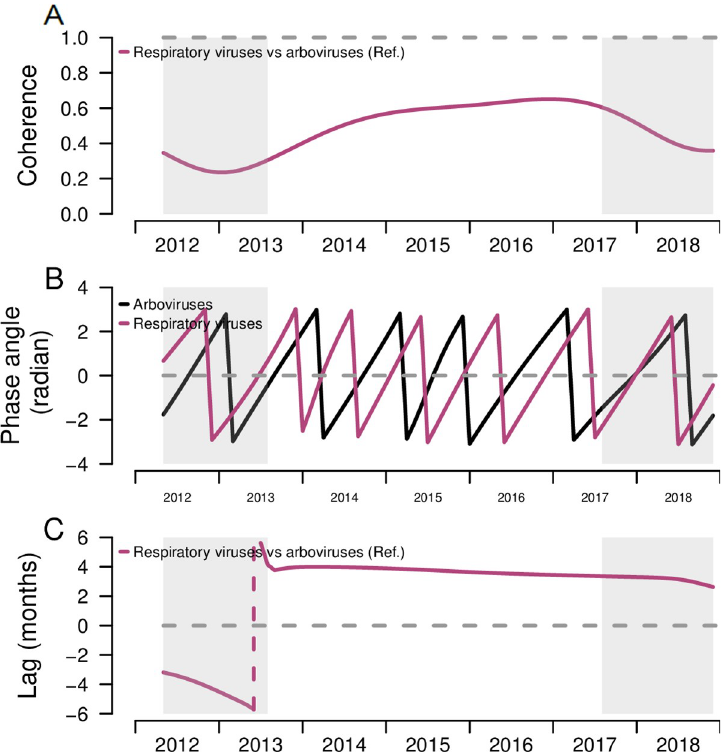
Fig 3. Coherence, phase angles, and lag of respiratory viruses and arboviruses among pediatric patients and comparison of both epidemic patterns, Sentinel Enhanced Dengue Surveillance System (SEDSS), Southern Puerto Rico, 2012–2018. A) Coherence comparing the similarity between the overall respiratory infection seasonal patterns to the arboviral infection patterns. Dashed line at 1 represents identical seasonal patterns and coherence at 0 refers to no association of two seasonal time-series. B) Phase angles of seasonal cycles of total respiratory infections and arboviral infections. C) Phase differences comparing the timing of respiratory infections seasonal cycles to arboviral infection epidemics. Dashed line at 0 refers to patterns of individual and overall respiratory infections occurring at the time (i.e. no difference in phase). Grey shading reflects the cone of influence, where edge-effects of the wavelet analysis influence the extraction and comparison of the season components. Negative values indicate the seasonal pattern of respiratory infections is behind arboviral infections, and positive values indicate the seasonal pattern of respiratory infections is ahead of arboviral